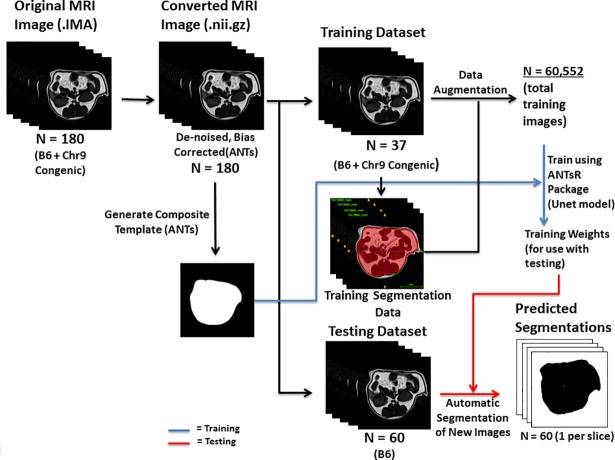
Flowchart illustrating the major steps employed in segmentation and quantification of subcutaneous and visceral fat in MR images.MR images were first converted to a format compatible with the ANTs software packages (NifTI; .nii.gz), and then processed for denoising and bias correction. 37 representative original MR images and their corresponding segmentation images from B6 mice and congenic mice were used for establishing the core training dataset. A novel data augmentation strategy was used to increase the number of training images from 37 to 60,552, which were used to train a U-net-based architecture. A testing dataset consisting of 60 MR images from 3 B6 mice was run through the model to test for accuracy of the method.